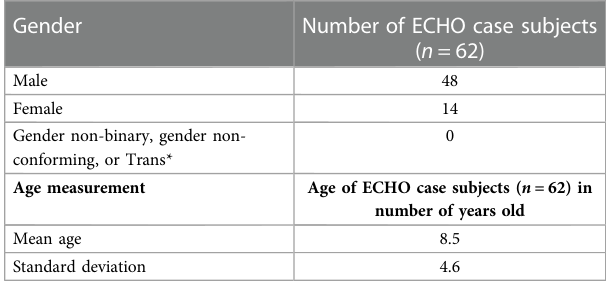
TABLE 2 Demographic information of case